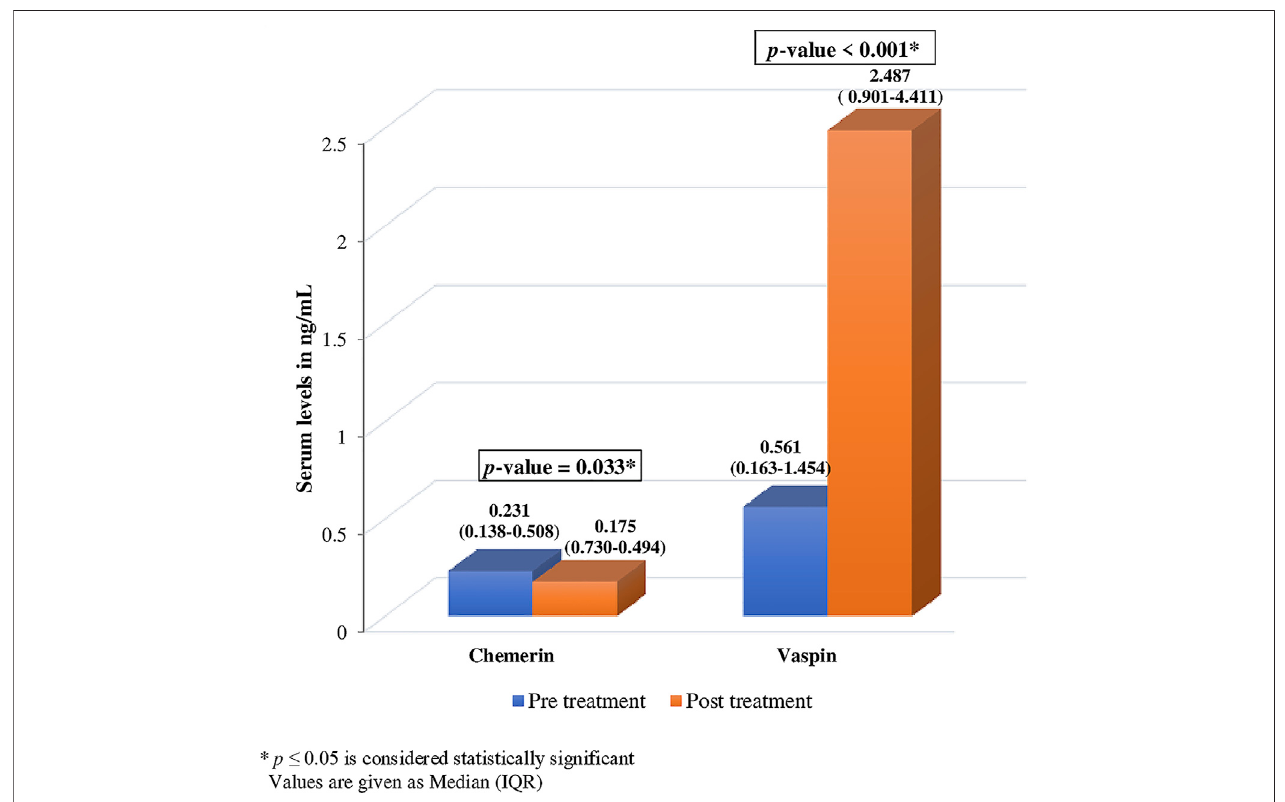
FIGURE 2 | Comparison of pre and post treatment levels of serum chemerin and vaspin.